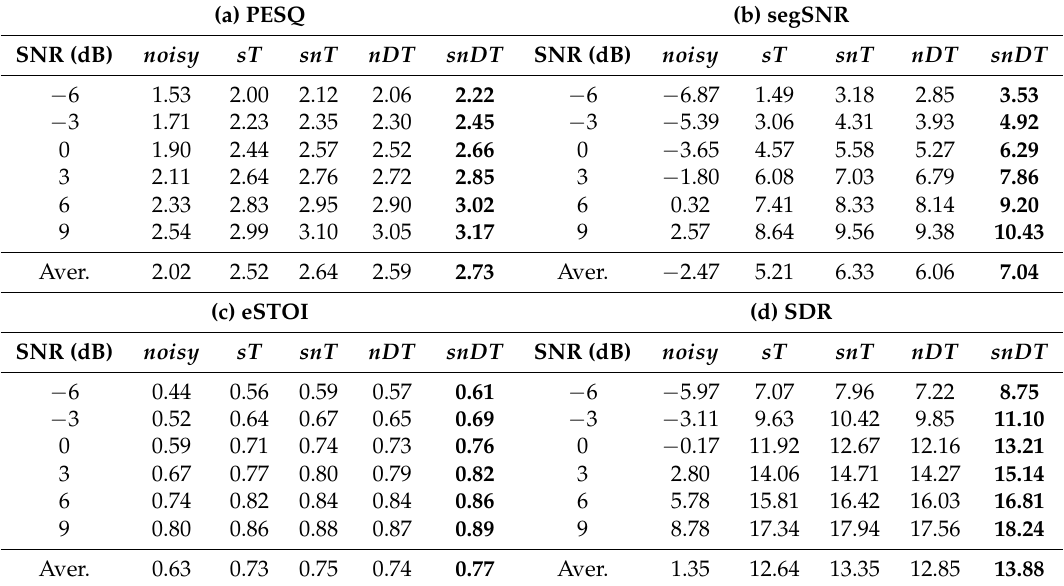
Table 1. Results of perceptual evaluation of speech quality (PESQ), segmental signal-to-noise ratio (segSNR), extended short-time objective intelligibility (eSTOI), and signal-to-distortion ratio (SDR) values of the proposed and baseline networks in the matched noise conditions, where − 6 and 9 dB cases are unseen SNR